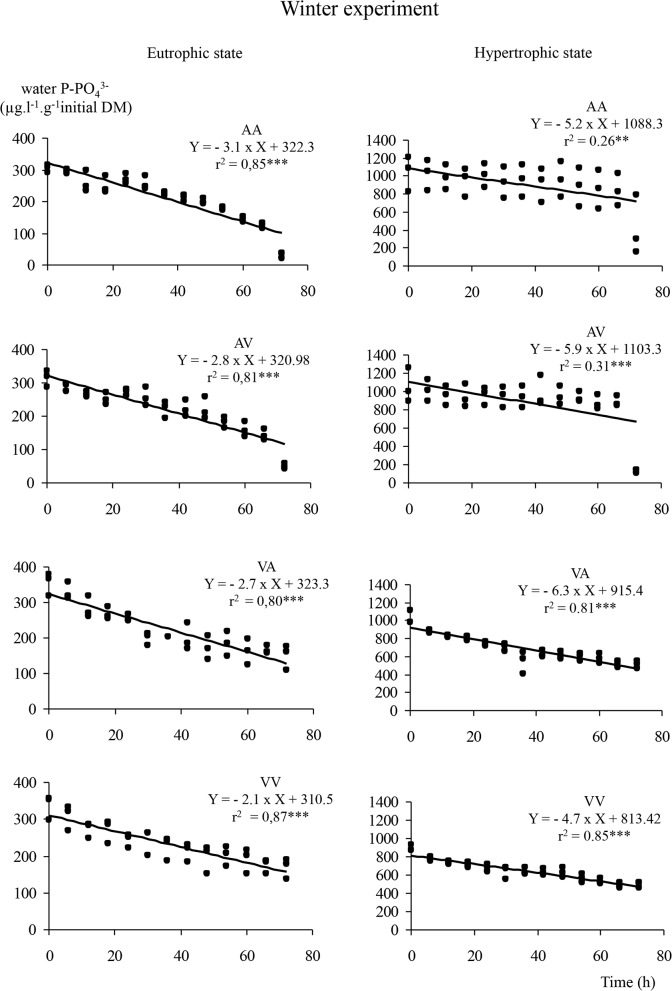
Dynamics of water phosphorus in winter.Dynamics of water phosphorus (in μg.l−1.g−1 of plant initial dry mass) and results of a linear model regression analyses under eutrophic and hypertrophic conditions, for all the possible combinations of water and subpopulation, during the winter experiment. In the legend, AA, AV, VA, VV include the information on the treatment, the first letter refers to the type of water and the second one to the subpopulation (e.g. AV means Alsatian water and Vosgian subpopulation).